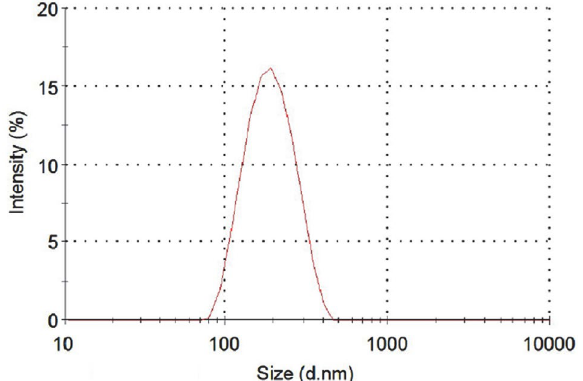
Figure 3. Hydrodynamic size distribution of the initial formulation